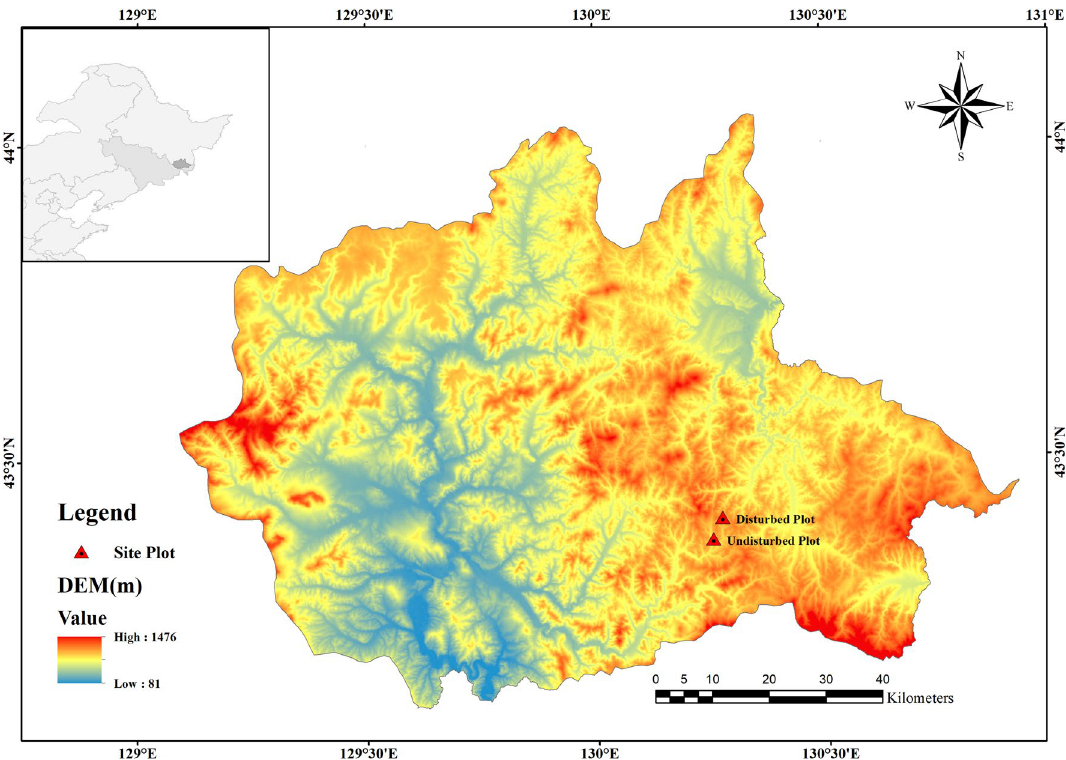
Figure 6. Location map of disturbed and undisturbed plots in Wangqing County, Northeast